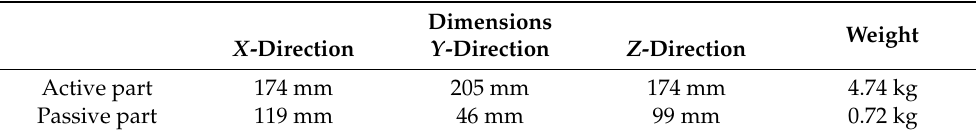
Table 1. Basic information of the docking